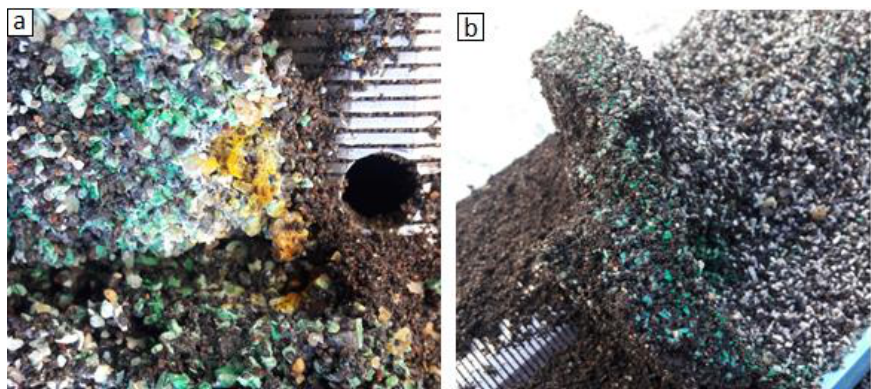
Figure 7. The ADES reactive substrate near the screen: ( a ) colors of the precipitates; ( b ) partial armoring.